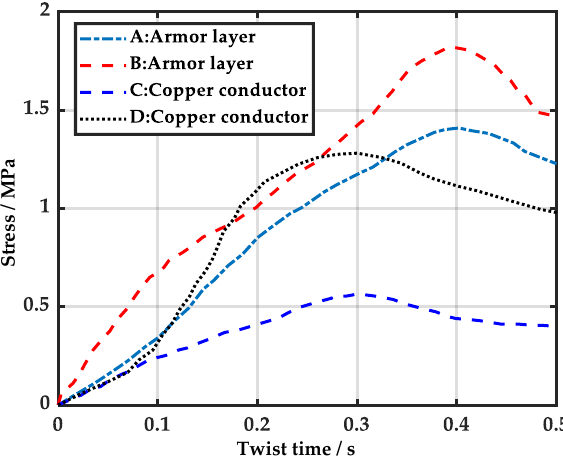
Figure 8. Stress distribution cloud of optical cell [41]. ( a ) Stress distribution cloud when the fiber is twisted clockwise; ( b ) Stress distribution cloud diagram when the fiber is twisted counterclockwise.